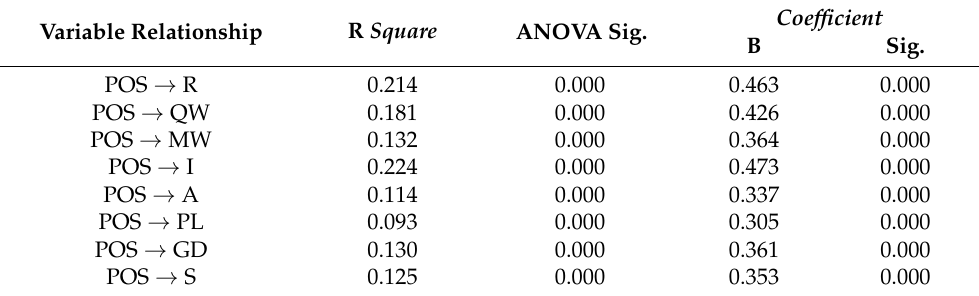
Table 5. Multiple linear regression test of perceived organizational support and subjective career